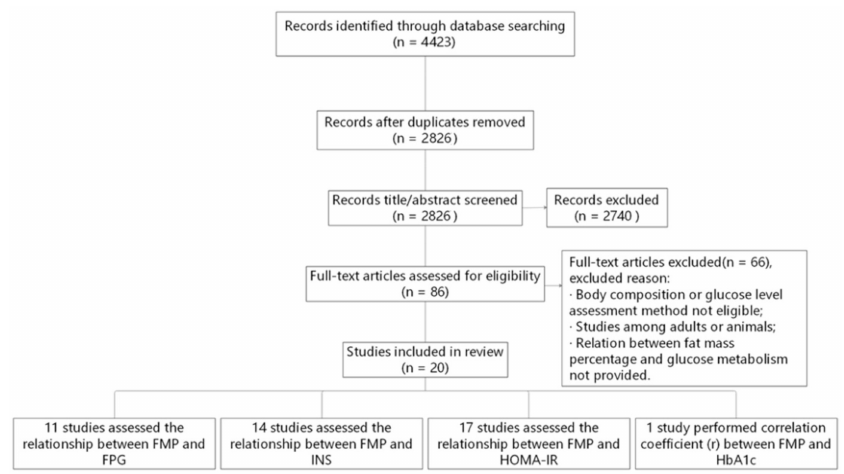
Figure 1. Flow diagram of the literature search and paper selection process. FMP, fat mass percentage; FPG, fasting plasma glucose; HbA1c, glycosylated hemoglobin A1c; HOMA-IR, homeostasis model assessment insulin resistance; INS, fasting plasma